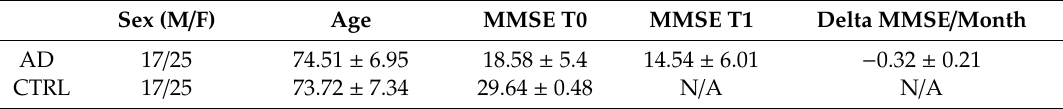
Table 6. Clinicopathological features of AD patients and una ff ected individuals enrolled for this study. Data are presented as average ± standard deviation. AD: Alzheimer’s disease; N / A: not available. Sex (M / F) Age MMSE T0 MMSE T1 Delta MMSE / Month AD 17 / 25 74.51 ± 6.95 18.58 ± 5.4 73.72 ± 7.34 29.64 ± 0.48 N / A N / A For plasma isolation, blood samples were collected in vacutainer tubes and centrifuged at 1800 ×